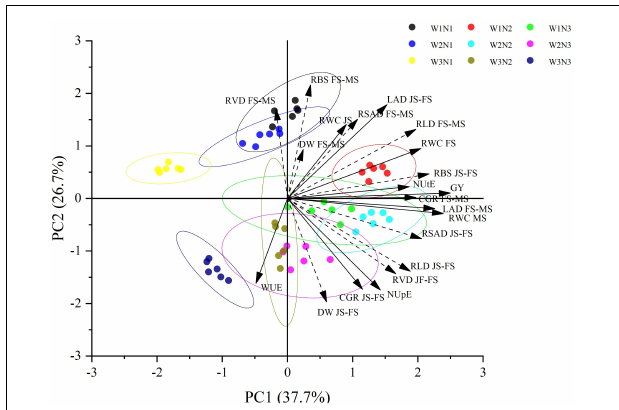
FIGURE 4 | The relationships between root characteristics and crop growth under irrigation and N split application in japonica rice. Dashed vectors represent the increase rate and the decline rate of root characteristics from jointing to full heading stage (JS-FS) and full heading to maturity stage (FS-MS), respectively. RLD, root length density; RSAD, root surface area density; RVD, root volume density; DW, root dry weight; RBS, root bleeding sap; LAD, leaf area duration; CGR, crop growth rate; RWC, root relative water content; GY, grain yield; WUE, water use efficiency; NUpE, N uptake efficiency; NUtE, N utilization